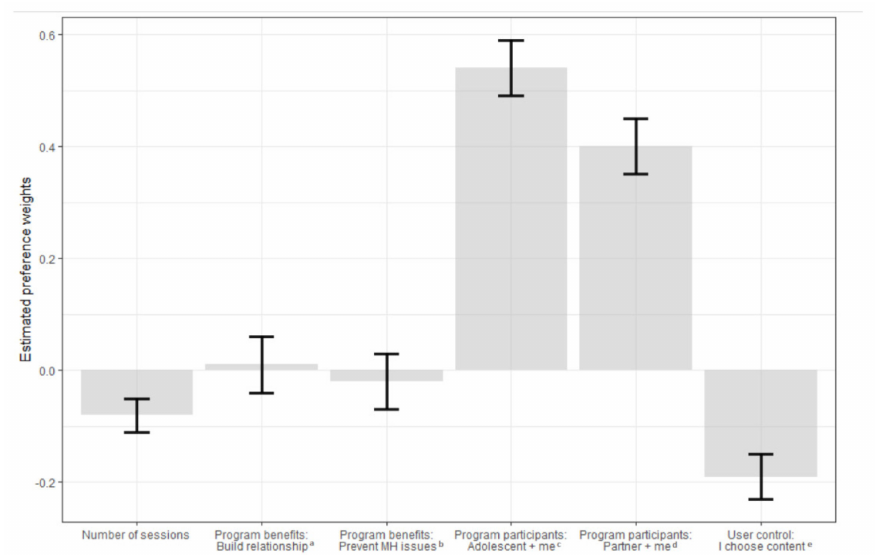
Figure 3. Estimated preference weights for attribute levels. Note . MH, mental health. Referent level for program benefits = ‘recognising and understanding issues with their adolescent’s mental health’. Referent level for program participants = ‘a program designed for fathers only’. Referent level for user control = ‘the user is allocated program topics based on expert